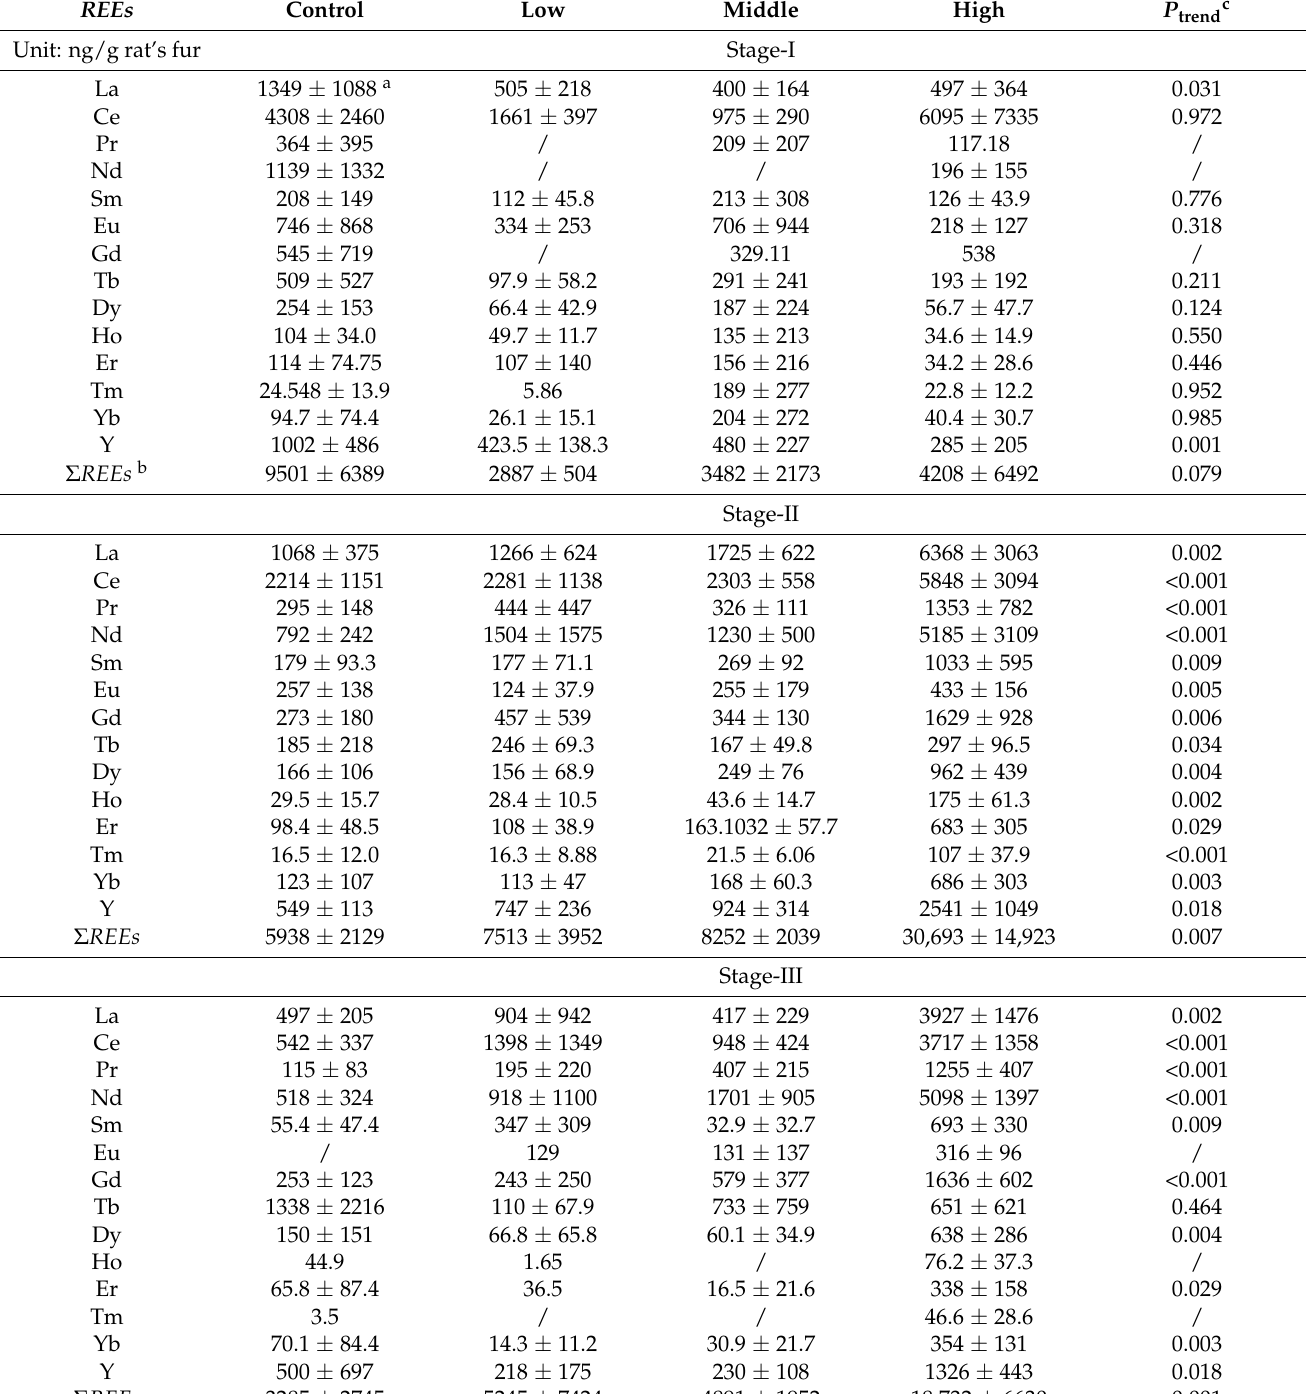
Table 1. The dose–response relationships between administration levels of 14 REEs to rats and their concentrations in rat fur samples collected in three